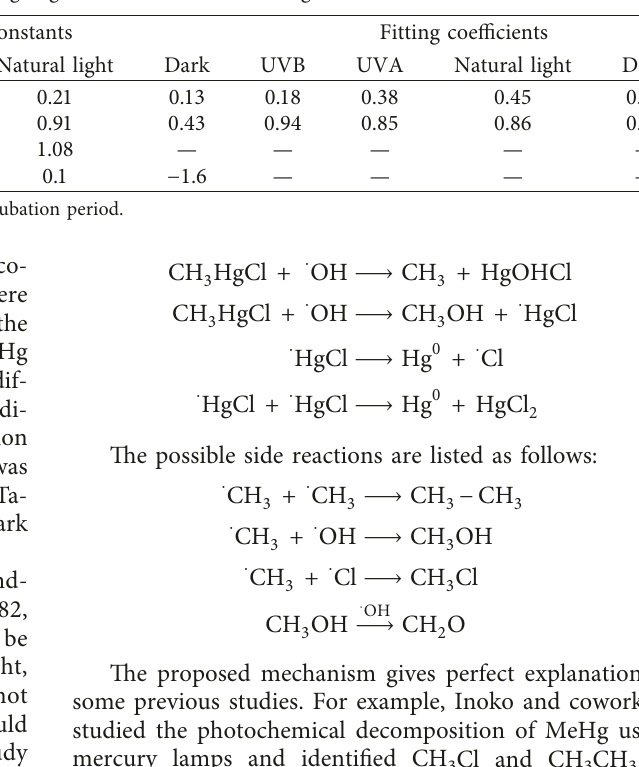
Table 1: Kinetic information of MeHg degradation under different light